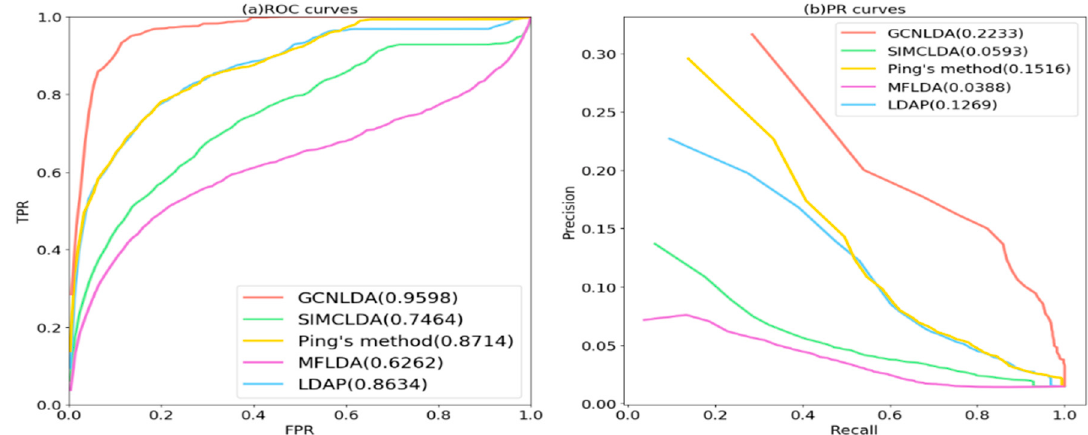
Figure 4. Receiver operating characteristic (ROC) and precision-recall (PR) curves of GCNLDA and other methods for all diseases. ( a ) ROC curves of all the methods; ( b ) PR curves of all the methods. Table 1. Area under the ROC curves (AUCs) of GCNLDA and other methods for all the diseases and 10 well-characterized diseases.